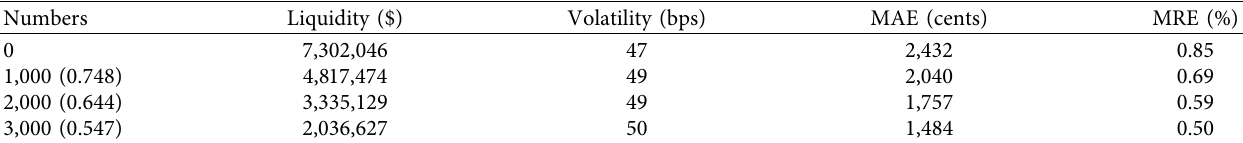
Table 14: Impact of hedgers on the quality of the stock index futures market.